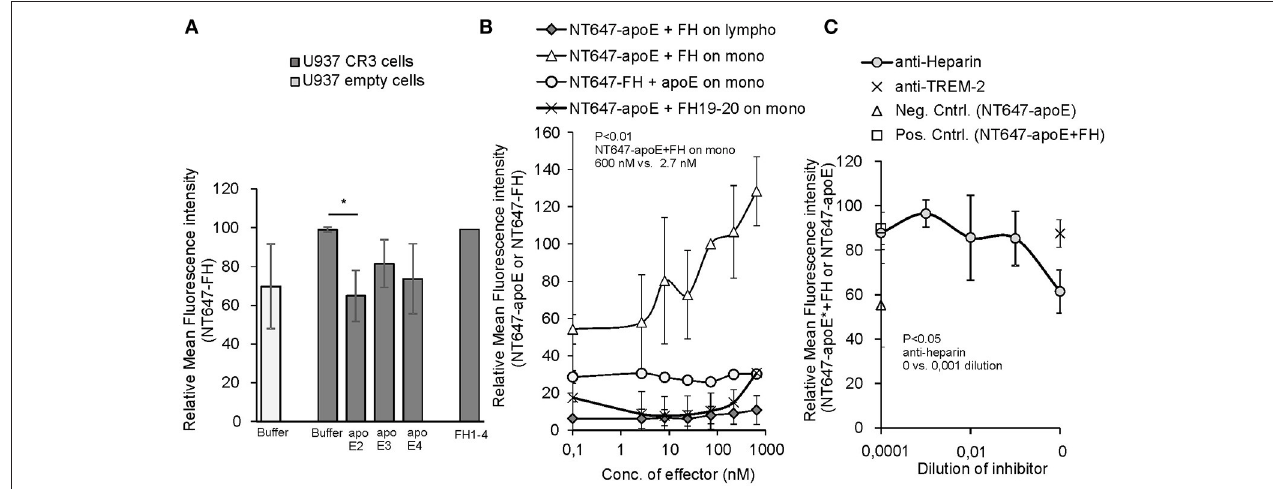
FIGURE 2 | Inhibition of Factor H/apoE binding to U937 and peripheral blood cells. (A) Binding of NT647-FH on U937 cells expressing CR3 in the absence (Buffer) or presence of 1.5 µ M of apoE2, 3 and 4 ( n = 3). Control cells without CR3 (empty cells) shows binding of FH without the receptor. Binding of NT647-FH in the presence of equal molarity of FH1-4 is shown. (B) Binding of NT647 labeled FH or apoE2 on peripheral blood cells with different concentrations of unlabeled inhibitor (FH or apoE). Levels are calculated as relative to apoE binding at 73nM FH concentration ( n = 4). (C) Inhibition of apoE + FH binding to monocytes in the presence of increasing concentrations of anti-heparin antibody. Anti-TREM-2 antibody was used as a negative control. Control (Neg. Cntrl. NT647-apoE) shows binding of apoE on the cells without FH incubation and Control (Pos. Cntrl. NT647-apoE + FH) binding of apoE in the presence of FH and apoE only ( n = 3). Statistical significance was calculated using one-way ANOVA supplemented with non-parametric Tamhane’s post-hoc multiple comparison test. Error bars indicate SD. Percentages of mean fluorescence intensities are shown as relative to the maximum intensity in each individual experiment. *= p <